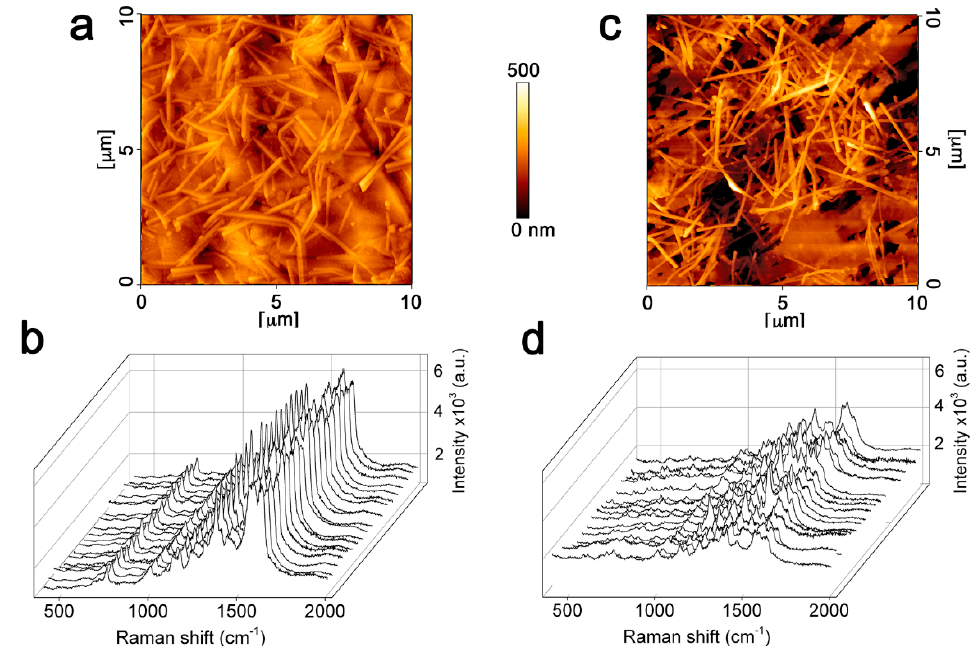
Figure 4. AFM topography of sprayed AgNWs on G-paper ( a ) and on a PTFE support ( c ). Random SERS spectra of Hb (1 × 10 − 6 M) as obtained by point-to-point mapping over 12 mm 2 areas with a step size of 100 µ m from sprayed AgNWs on G-paper ( b ) and on a PTFE support ( d ).